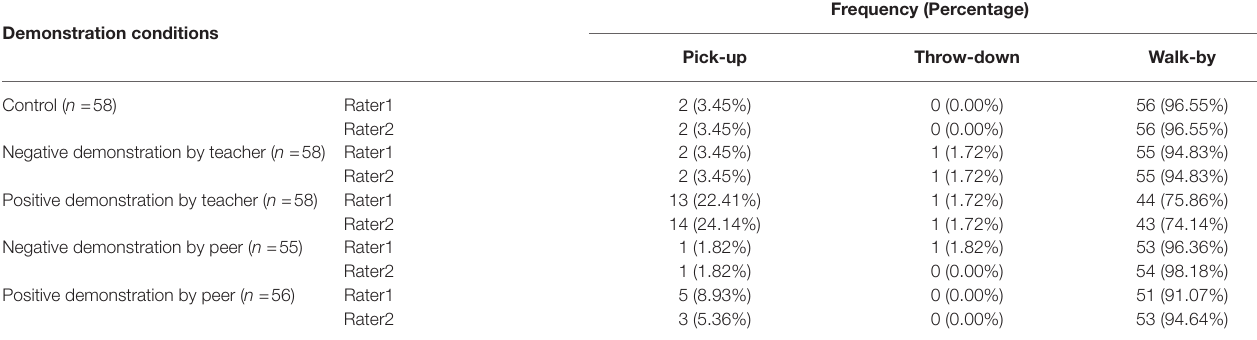
TABLE 1 | Crosstabulation of coding consistency